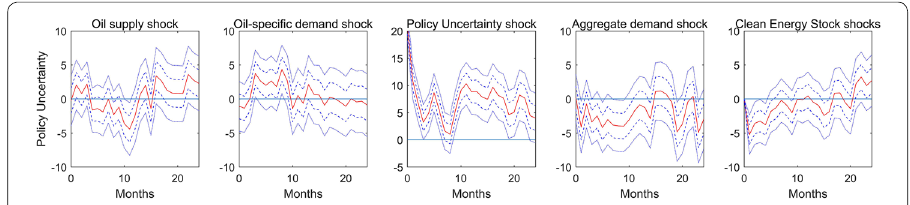
Fig. 5 Responses of policy uncertainty to one and two standard deviation structural shocks: 2001:01– 2018:12. Notes: The figure shows the impulse response functions to one and two standard deviation structural shock, the order of SVAR model is oil supply shocks, aggregated demand shocks, oil specific demand shocks, economic policy uncertainty index and the real stock returns of the clean industry described in the text. Point estimates are reported with one- and two-standard error bands constructed using a recursive-design wild